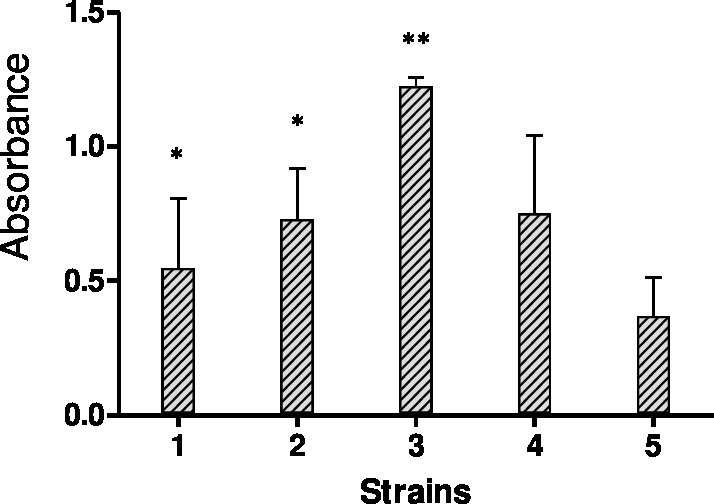
Results of crystal violet staining.Each graph represents data of the mean of individual biofilms (OD595 nm). Each experiment was performed six times and biofilm production quantities are reported as the arithmetic mean of absorbance values.